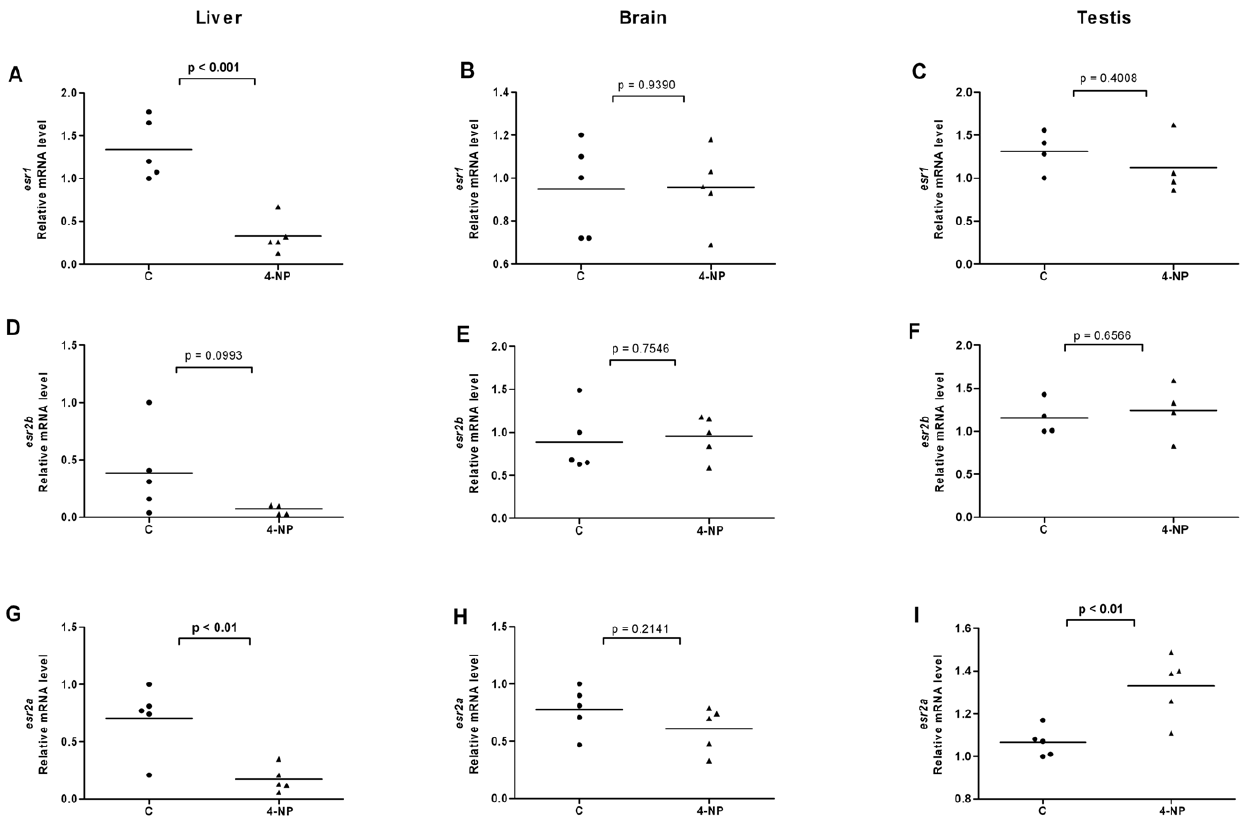
Figure 9. Effects of 4-nonylphenol on esr expression in liver, brain and testis of male fish. Expression levels of esr1 (A–C), esr2b (D–F) and esr2a (G–I) in liver, brain and testis following exposure to 4-NP (1 m M). doi:10.1371/journal.pone.0009678.g009 in brain of male zebrafish (although not with high significance; Figure S4).